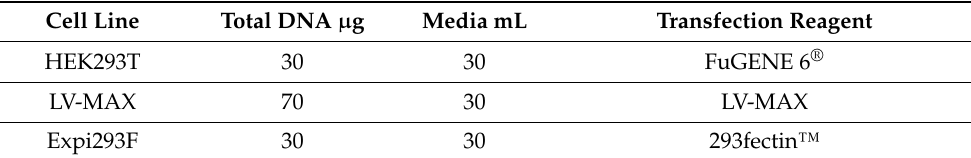
Table 2. Total amount DNA used for transfection and recommended by manufacturer.